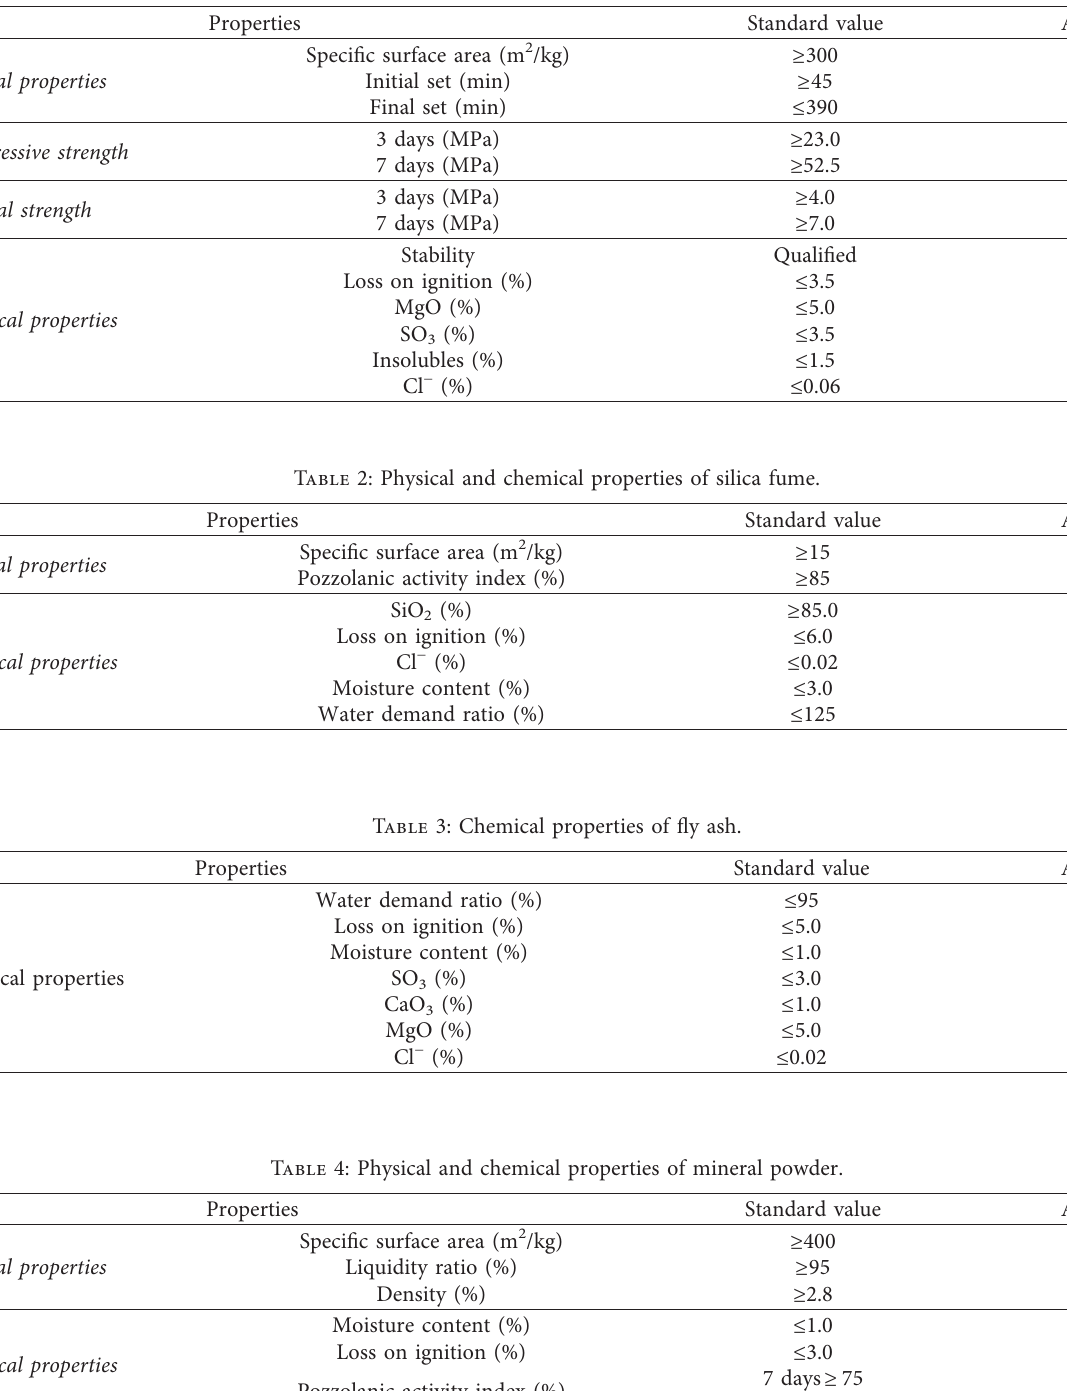
Table 1: Physical and chemical properties of cement.